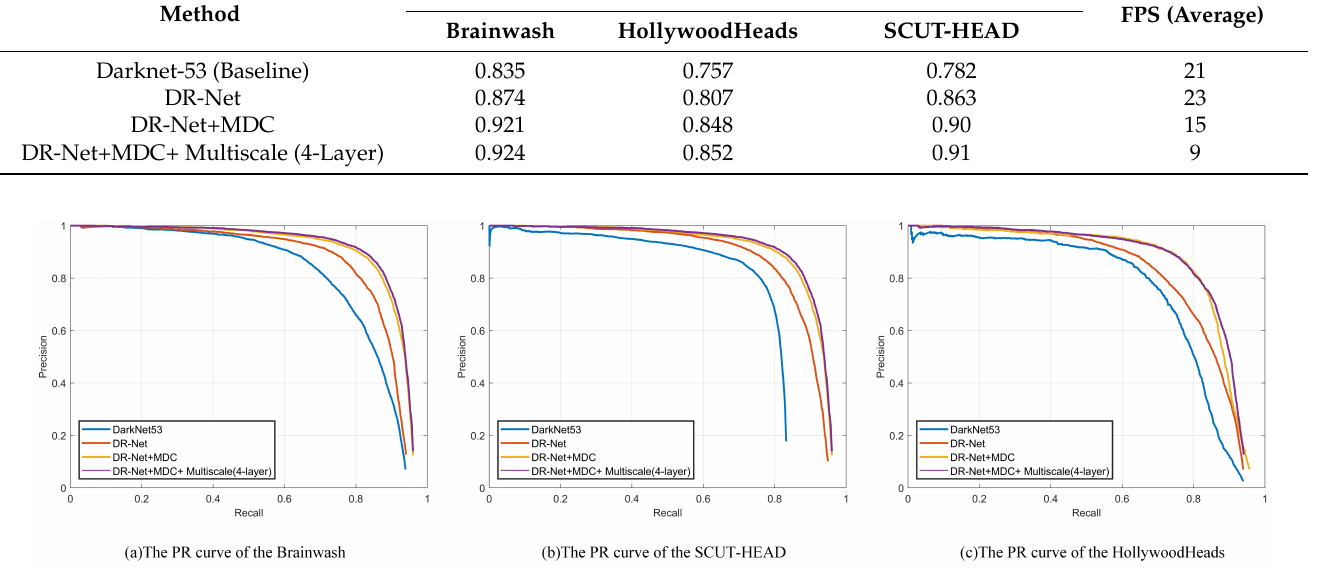
Figure 8. The PR curves of the ablation experiments on three datasets.